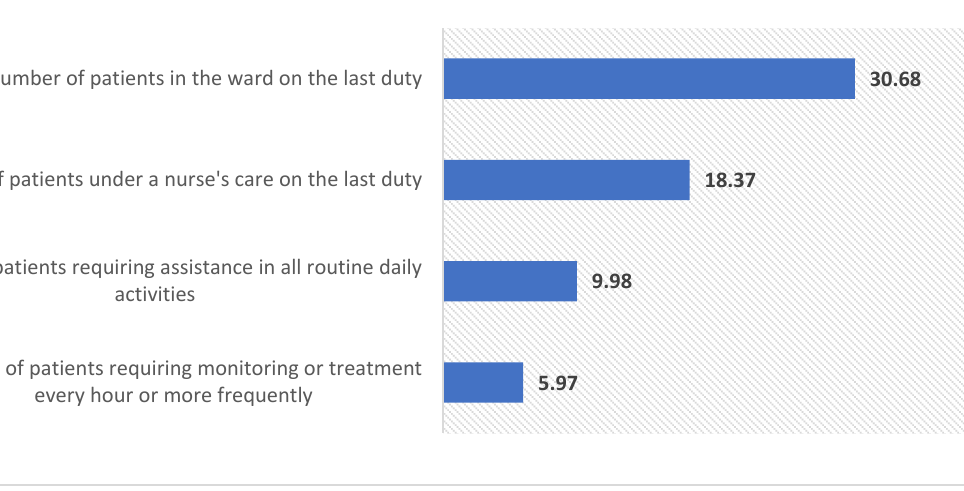
Figure 1. The characteristics of workload based on the number of patients under care during the most recent shift. Labels in the image represent median values.